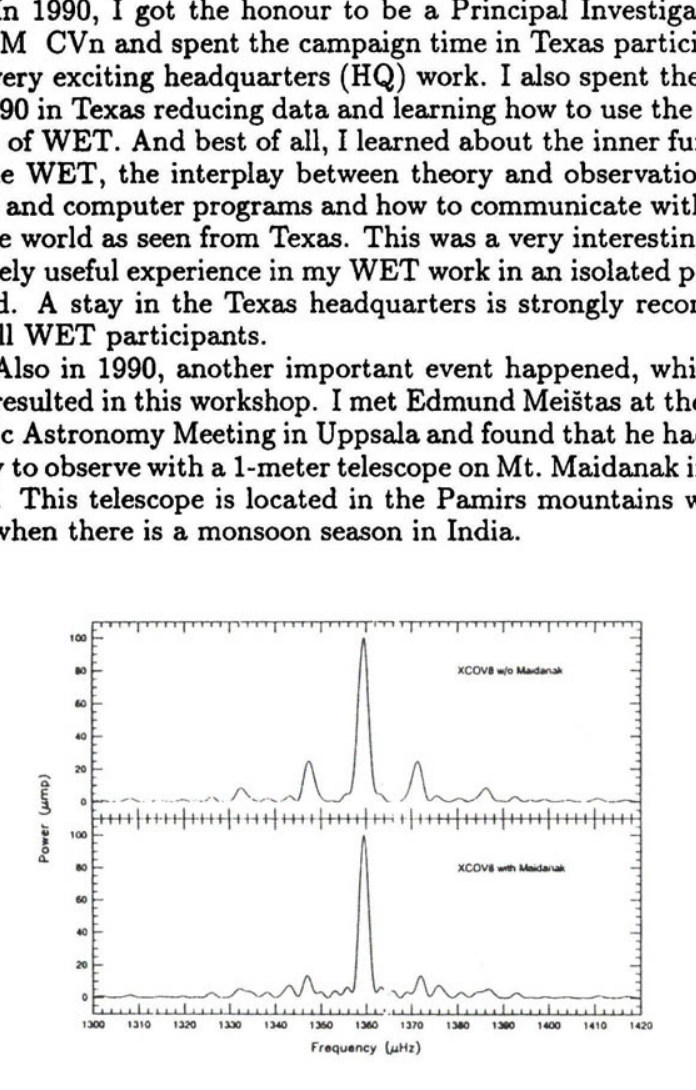
Fig. 1. Window function without and with the data from Mt. Maidanak for PG 2131+066 observed in September